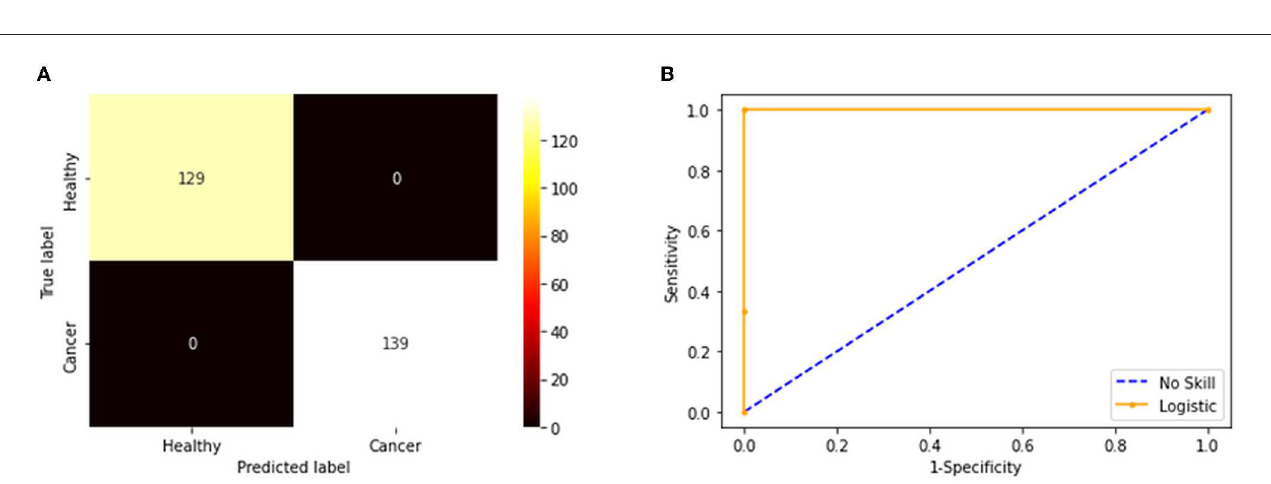
FIGURE7 Confusion matrix and ROC curve achieved with fused features. (A) Confusion matrix. (B) the ROC